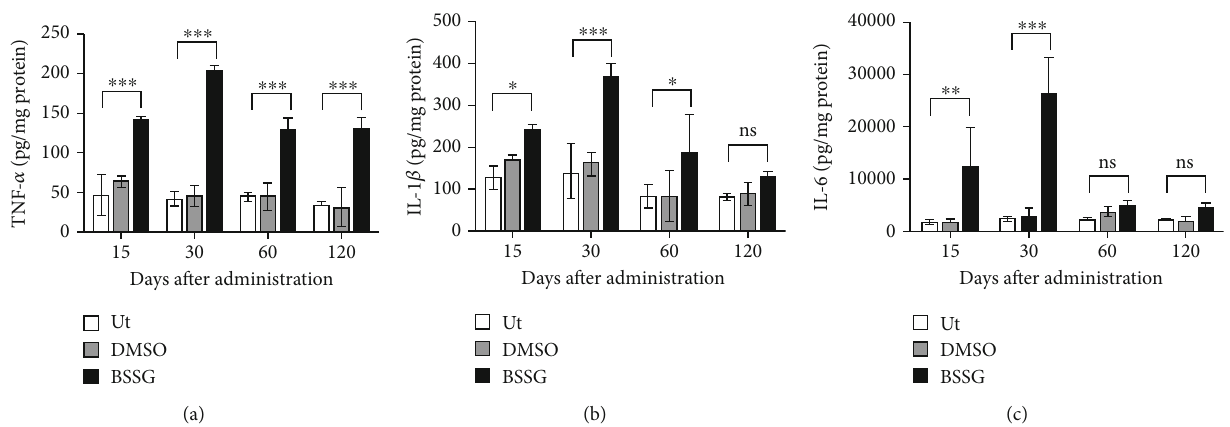
Figure 10: Levels of proin fl ammatory cytokines in the substantia nigra after BSSG intranigral injection. ELISA was used to measure protein levels of (a) TNF- α , (b) IL-1 β , and (c) IL-6. All values represent the mean ± SD ( n = 3 rats per time point per experimental condition). Two- way ANOVA and Bonferroni post hoc test were applied for statistical analysis. The levels of signi fi cance were ∗ P < 0 : 05 , ∗∗ P < 0 : 01 , and ∗∗∗ P < 0 : 001 . ns: not signi fi